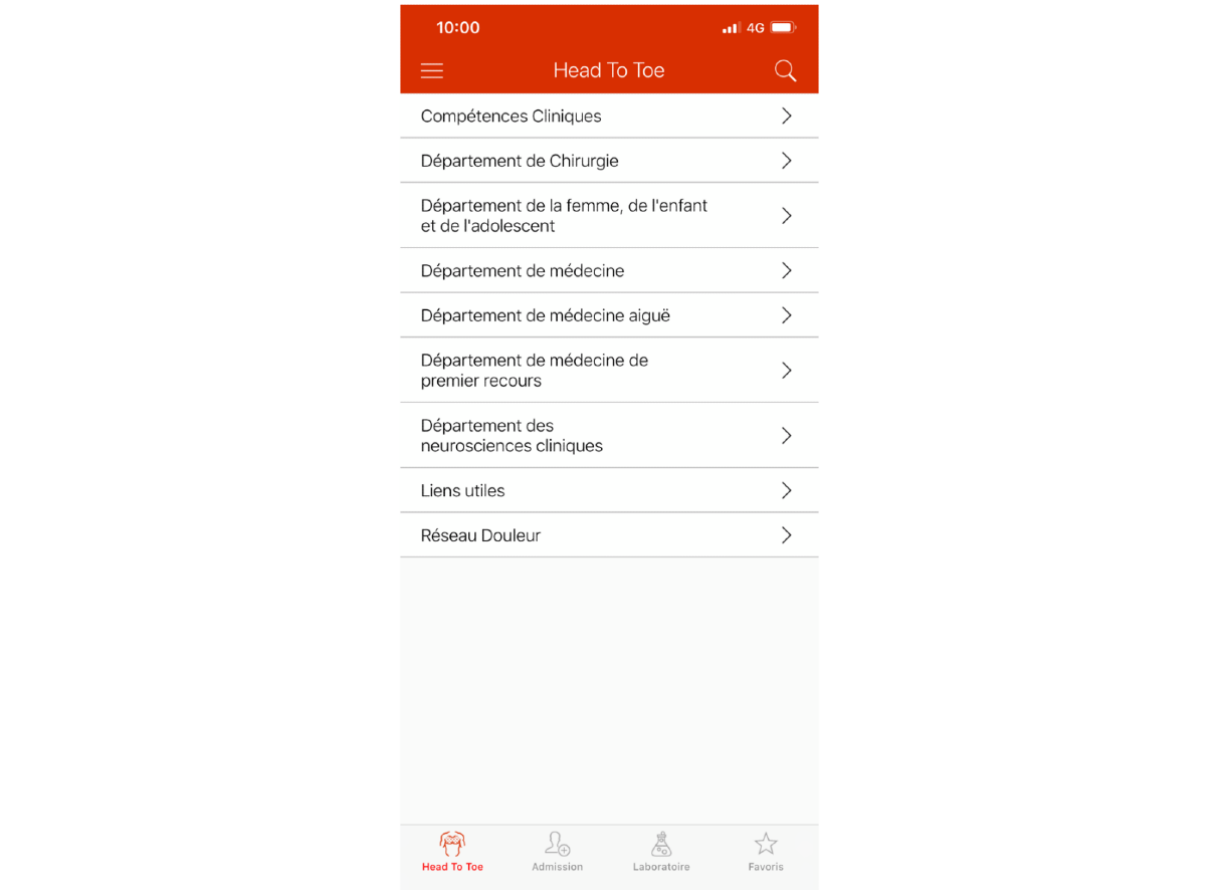
Figure 2. The knowledge base of the HeadToToe platform (in French). Users can navigate through different medical specialties organized as